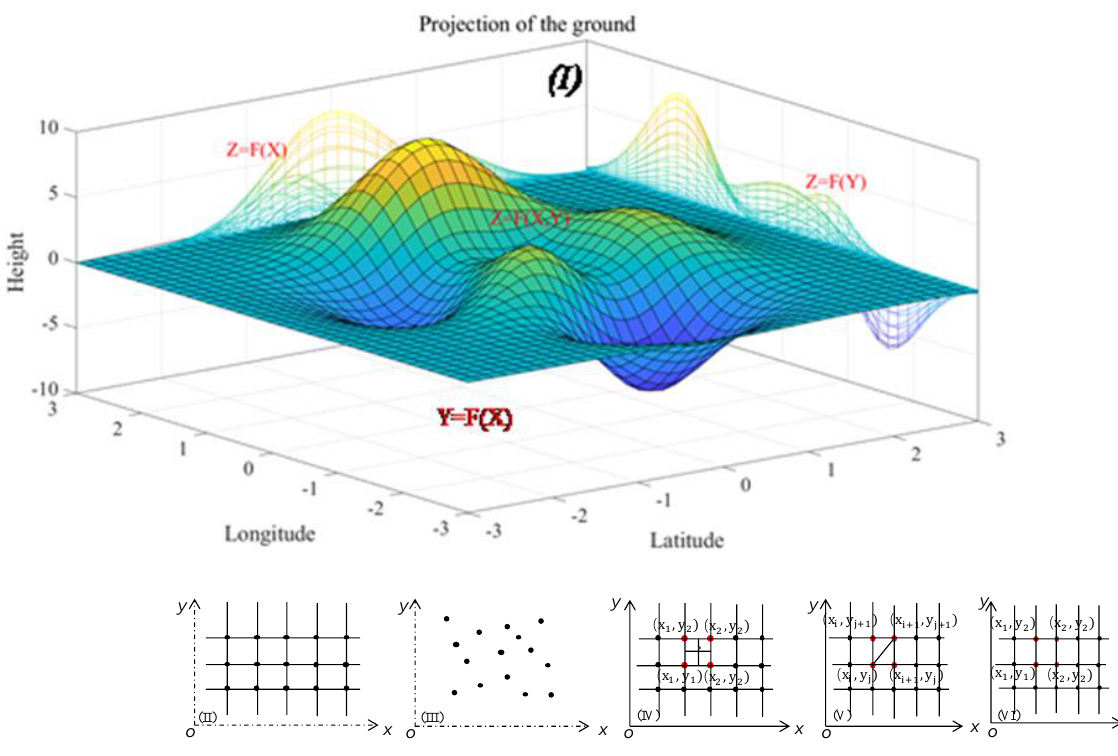
Figure 4. The continuous curve of the continuous ground surface projected on the XOZ and YOZ surfaces ( I ), Figure ( II ), ( III ) are the regular node and the scattered node of the interpolation node, respectively. Figures ( IV ), ( V ), and ( VI ) are the nearest neighbor interpolation, process of piecewise linear interpolation and bilinear interpolation.